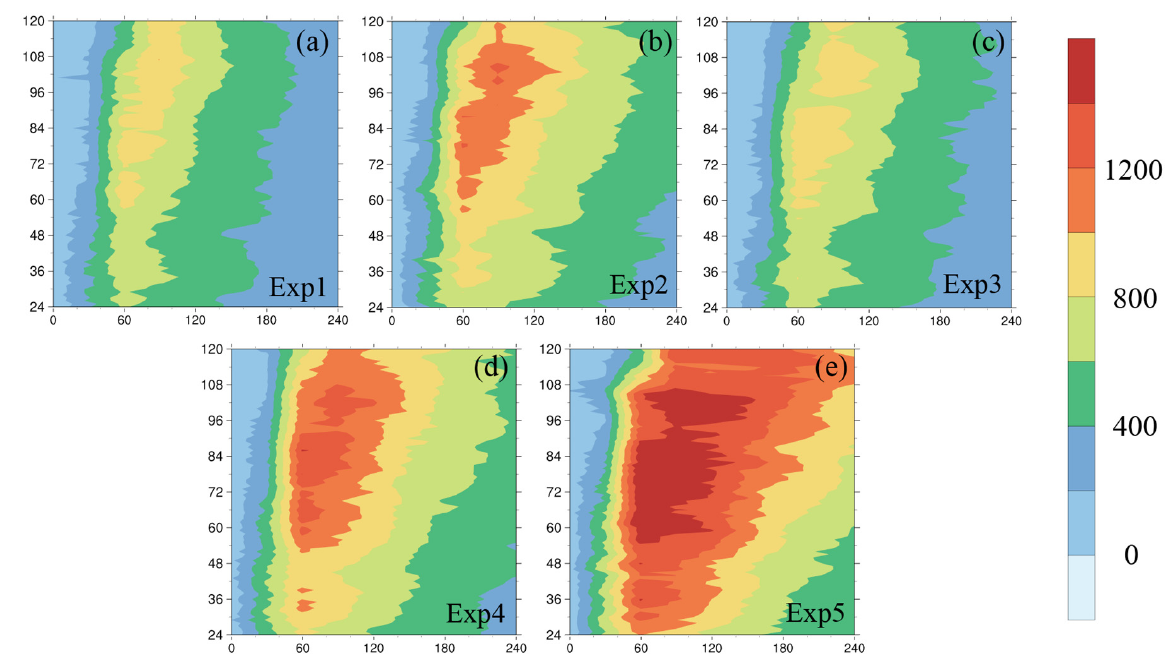
Figure 14. Hovmöller diagrams of the azimuthally averaged latent heat flux H L , T simulated by the five experiments ( a – e ). The abscissa is the radial distance from the center of the TC, and the ordinate is the simulation time.